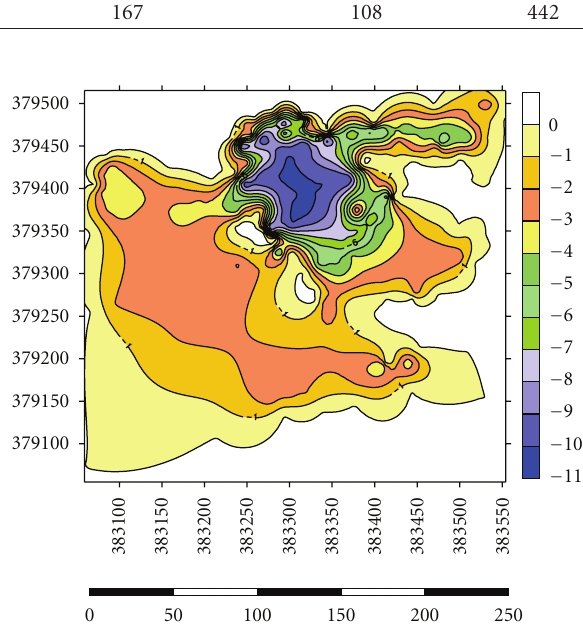
Figure 5: Showing depth at Lake A of the